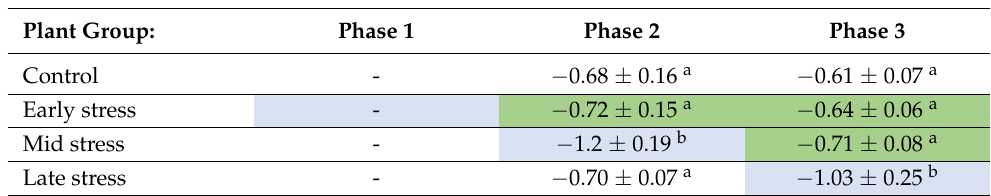
Table 2. Leaf water potential (MPa). Average values for measurements starting 3 days after the beginning of the treatments. One measurement per day starting at 11 a.m. Average of 9 plants. (Legends as in Table 1).